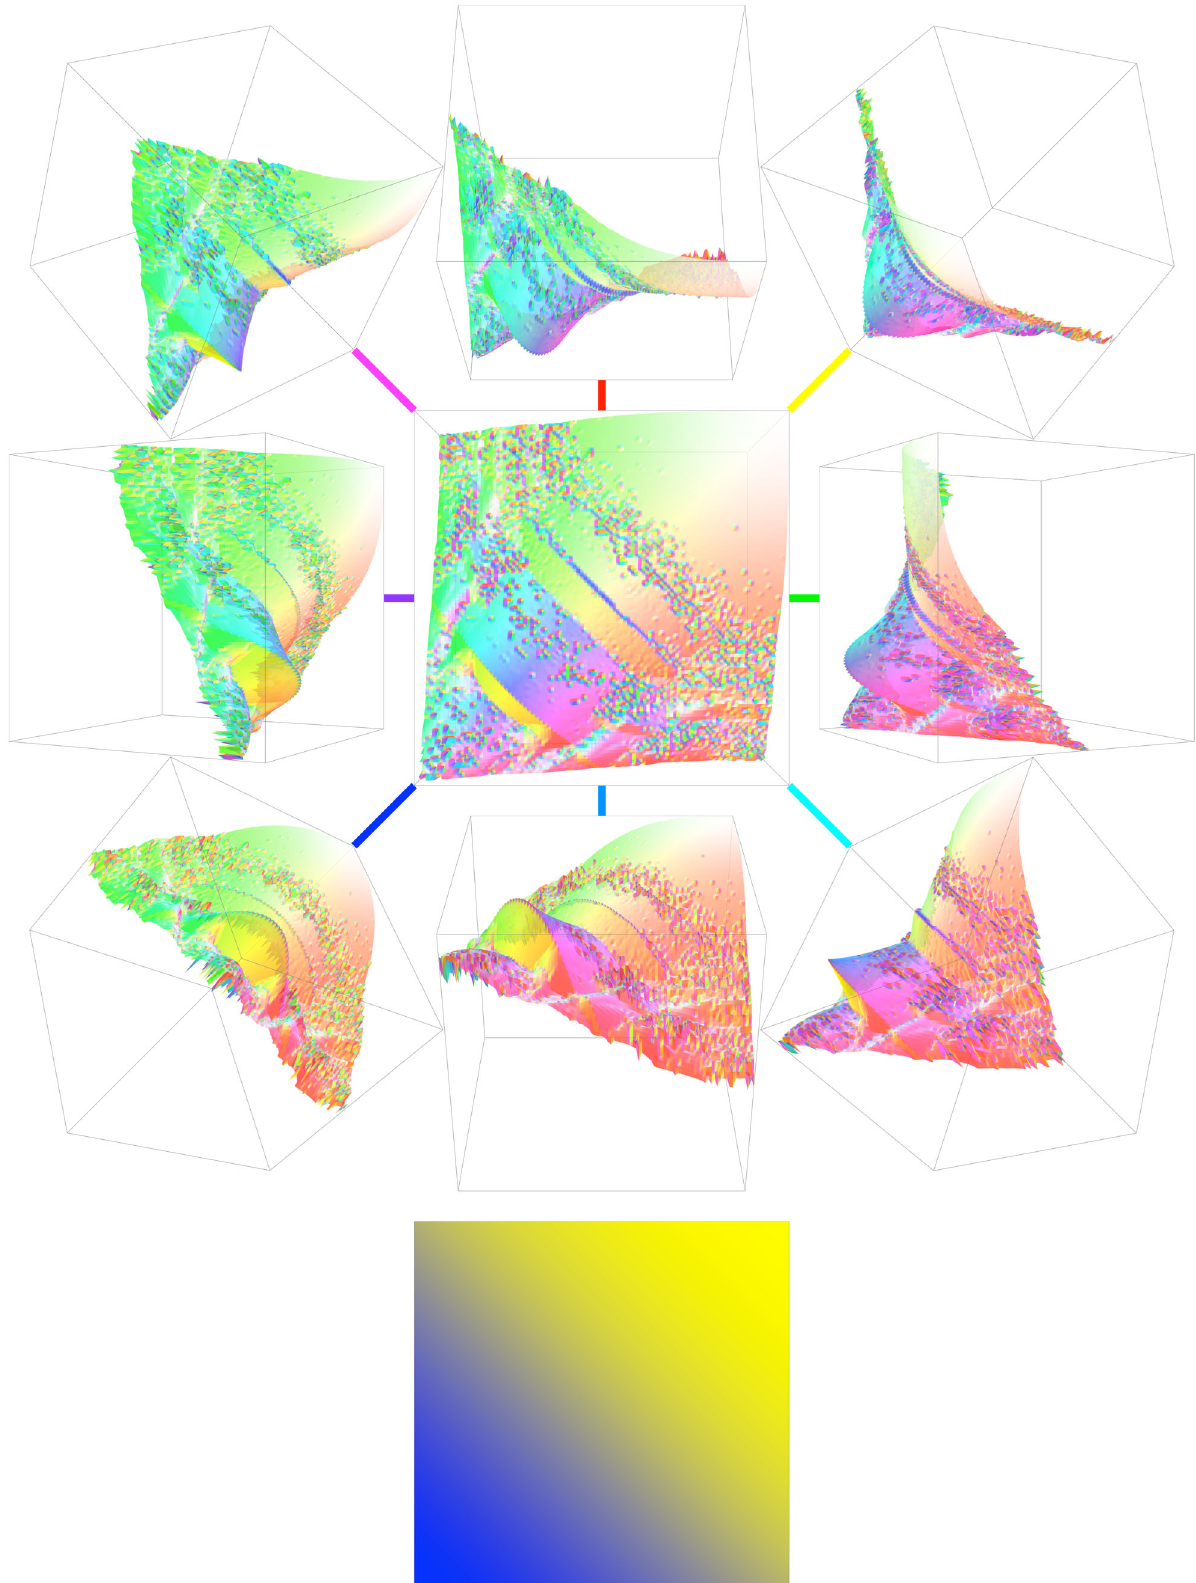
FIG. 8 323 · 3 -family optimal density surface ( 3 × 3 grid of cubes) and face areas (bottom